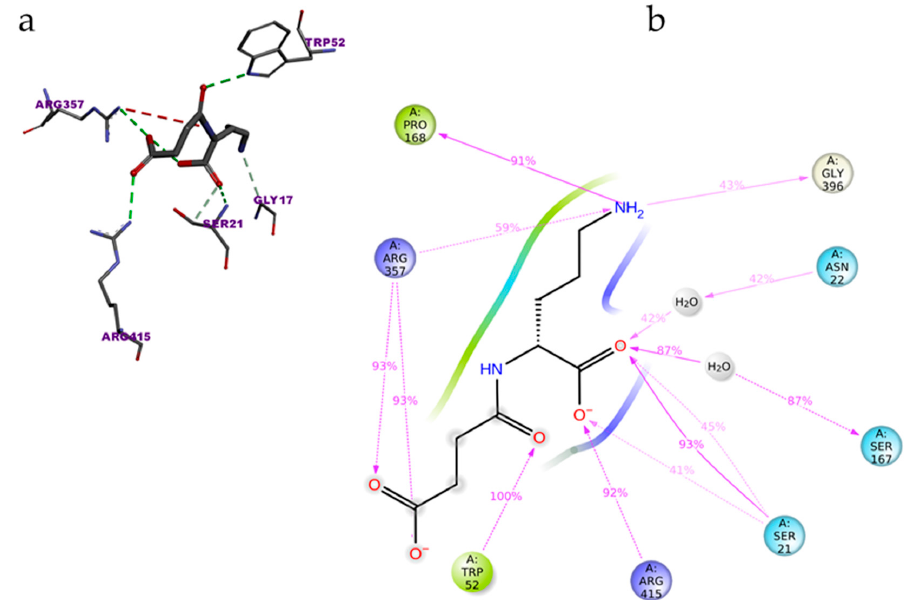
Figure 2. Interaction of N-2-Succinyl-ornithine with PvdA: amino acids of PvdA interacting with the top binder N-2-succinyl-ornithine ( a ); and 2D-interaction plot of N2-Succinyl-ornithine interacting with PvdA. ARG357 was found to make three interactions with PvdA ( b ).